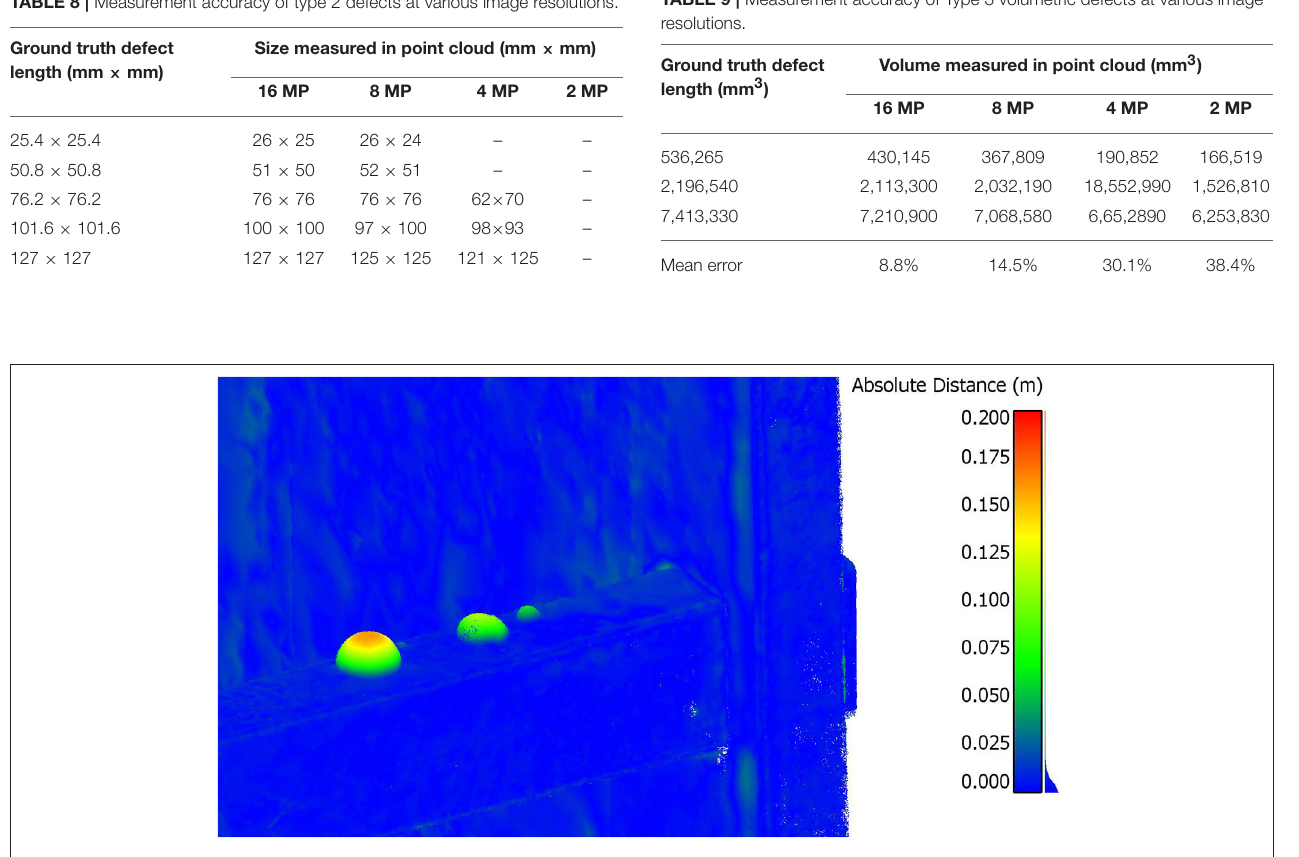
FIGURE 13 | Volumetric 3D change